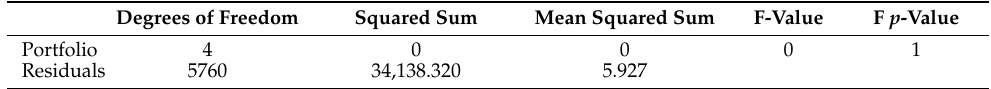
Table 3. One-way ANOVA test of the simulated portfolios’ returns.